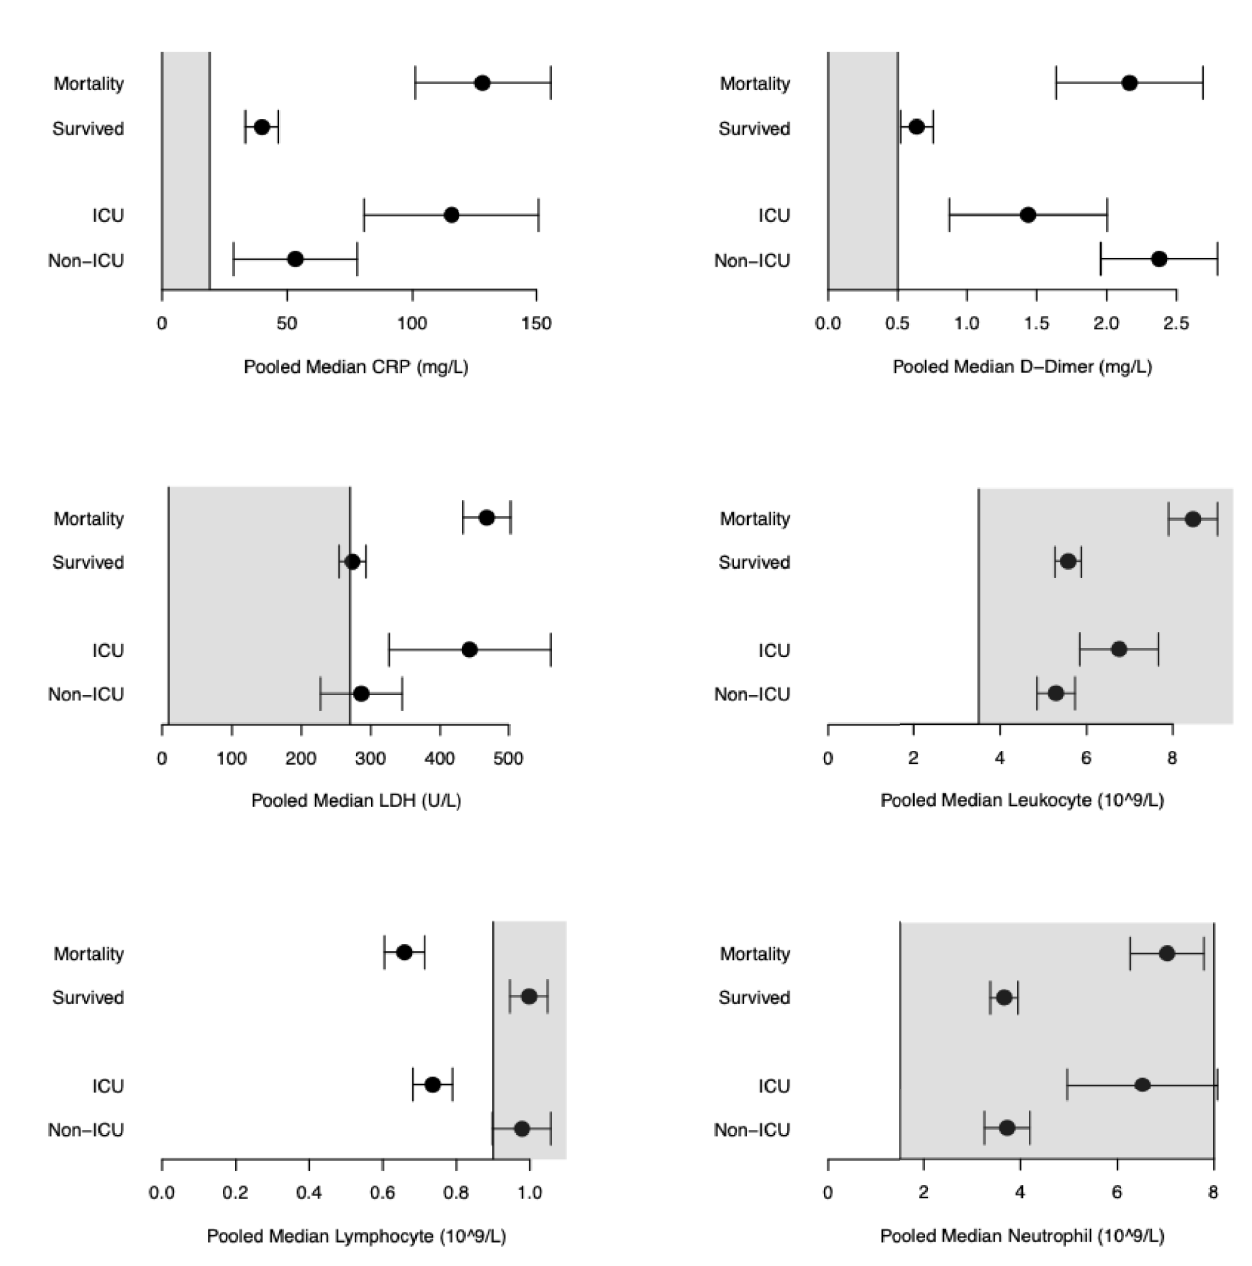
Fig 5. Pooled median estimates of selected indicators along with their normal laboratory ranges among patients who died, patients who survived, ICU-admitted patients, and non-ICU admitted patients. ICU = Intensive care unit, CRP = C-reactive protein, LDH = Lactate dehydrogenase.